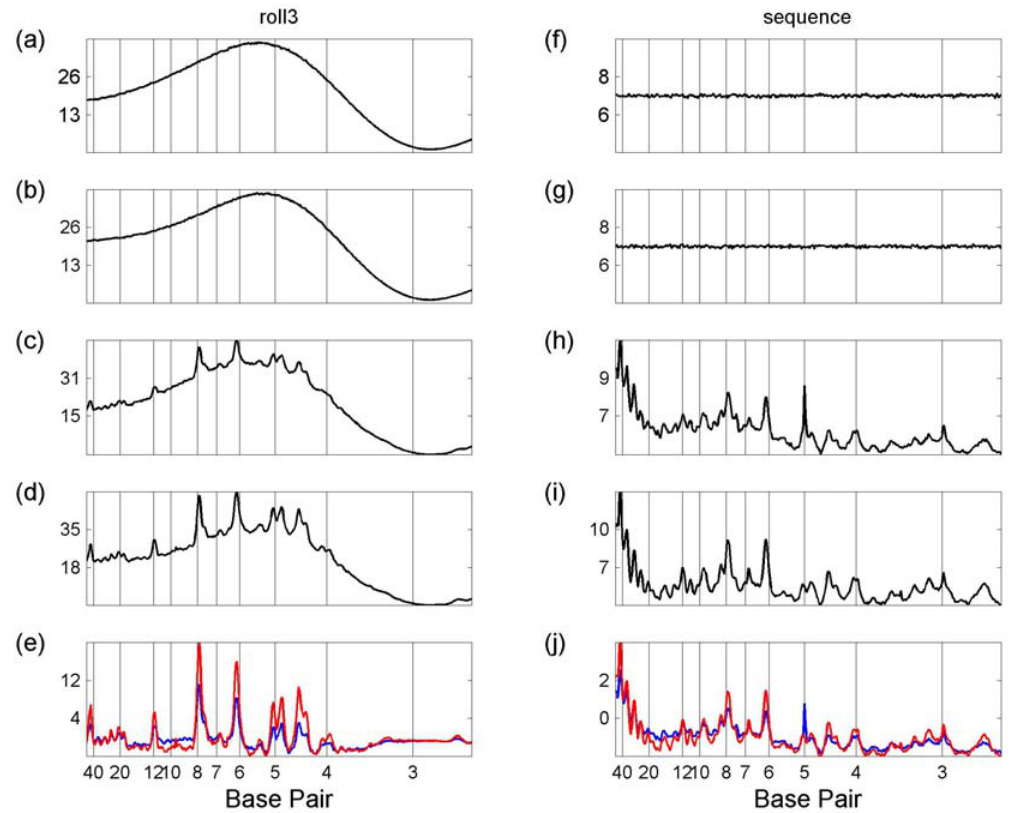
of chromosome 21 (obtained by subtracting panel (a) from panel (c)) in blue with that of chromosome 22 (obtained by subtracting panel (b) from panel (d)) in red. Figure 1 . Comparing Spectra. Left-hand panels are roll3, right-hand are sequence. (a) roll3 spectra of shuffled chromosome 21; (b) roll3 spectra of shuffled chromosome 22; (c) roll3 spectra of chromosome 21; (d) roll3 spectra of chromosome 22; (e) roll3 difference spectra of chromosome 21 (blue line) and chromosome 22 (red line). (f) sequence spectra of shuffled chromosome 21; (g) sequence spectra of shuffled chromosome 22; (h) sequence spectra of chromosome 21; (i) sequence spectra of chromosome 22; (j) sequence difference spectra of chromosome 21 (blue line) and chromosome 22 (red line). In each case the y- axis is the spectral value divided by 10,000. All figures were drawn in Matlab